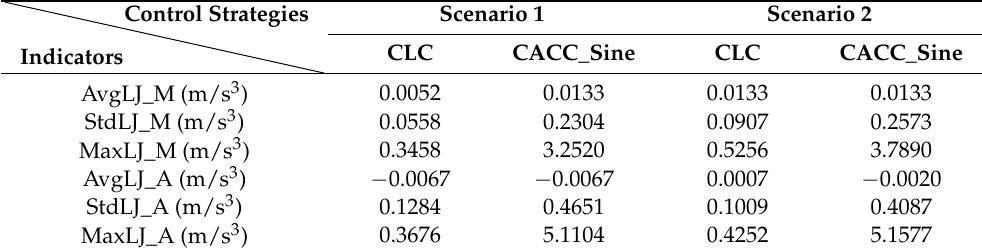
Table 5. Indicator comparison for longitudinal jerks of two control